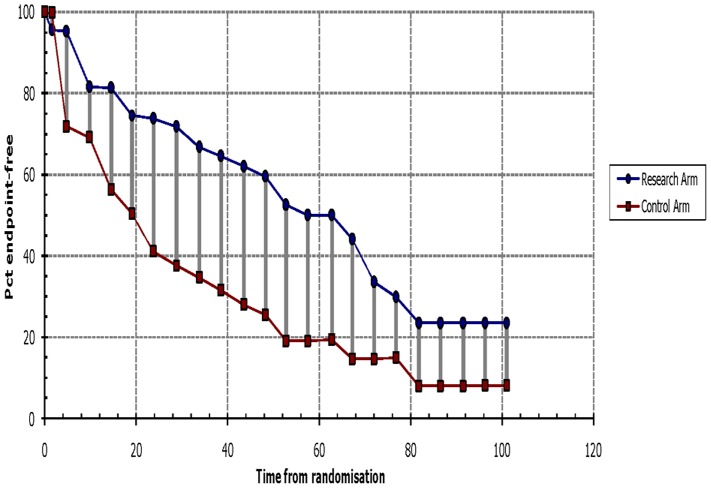
Survival data for disease-free survival based on Kaplan-Meier curve by Tierney’s method from Chau GY’ study.It is similar to the orignal graph(figure S2),which means the HR value we extrated is close to the original value.